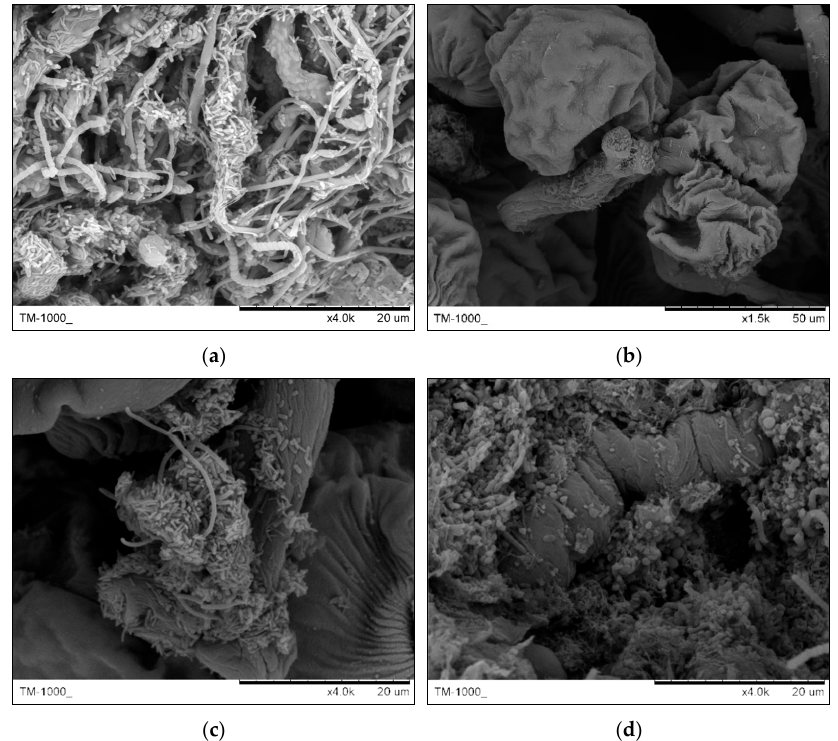
Figure 8. Stalks and filaments acting as skeletons of structure in granules. ( a ) Interlaced structure of stalks and filaments in the surface; ( b ) bell bodies of Epistylis supported by stalks; ( c ) stalk colonized by various bacteria (rods, cocci and filaments); ( d ) dead stalk buried inside of granule.